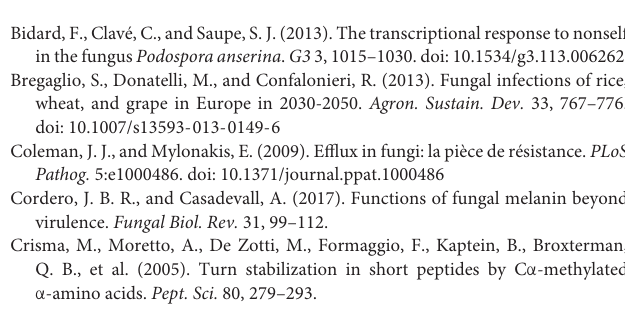
complete medium (CM). Supplementary Figure 8 | RT-qPCR analysis of some selected Pyricularia oryzae genes performed on a Rotor-Gene Q 2plex (Qiagen) by using as template RNA extracted from 3 days old mycelium of P. oryzae untreated or treated for 3 h with pep 4Rink. (A) Relative expression of selected genes found as upregulated in the RNA-seq analysis; (B) Relative expression of selected genes found as downregulated in the RNA-seq analysis. Relative expression was analyzed using the Rotor-Gene v. 2.0.3.2 software (Qiagen) and the tool REST by using P. oryzae actin (MGG_03982) and glyceraldehyde-3-phosphate dehydrogenase (MGG_01084) as normalizers. Error bars indicate standard errors calculated from two biological replicates. Supplementary Table 1 | List of primers used in the RT-qPCR analysis. Supplementary Table 2 | List of all the differentially expressed genes (DEGs) identified by RNA seq analysis at 3 h after Pyricularia oryzae treatment with Pep 4Rink. Supplementary Table 3 | FunCat Categories assigned to up-regulated genes at 3 h post treatment. Categories were ranked based on the adjusted p -value < 0.05 calculated with the Fisher’s enrichment exact test. The percentage of genes assigned to a specific category was calculated with respect to the total number of genes assigned to all the categories identified. Supplementary Table 4 | FunCat Categories assigned to down-regulated genes at 3 h post treatment. Categories were ranked based on the adjusted p -value < 0.05 calculated with the Fisher’s enrichment exact test. The percentage of genes assigned to a specific category was calculated with respect to the total number of genes assigned to all the categories identified. Supplementary Table 5 | Go Categories assigned to up-regulated genes at 3 h post treatment. GO names were ranked based on the adjusted p -value < 0.05 calculated with the Fisher’s enrichment exact test. The percentage of genes assigned to a specific GO name was calculated with respect to the total number of genes assigned to all the categories identified. BP = Biological Process; CC = Cellular Component; MF = Molecular function. Supplementary Table 6 | Go Categories assigned to down-regulated genes at 3 h post treatment. GO names were ranked based on the adjusted p -value < 0.05 calculated with the Fisher’s enrichment exact test. The percentage of genes assigned to a specific GO name was calculated with respect to the total number of genes assigned to all the categories identified. BP = Biological Process; CC = Cellular Component; MF = Molecular function. Supplementary Table 7 | Pyricularia oryzae genes up-regulated after 3 h from peptide treatment. Supplementary Table 8 | Pyricularia oryzae genes down-regulated after 3 h from peptide